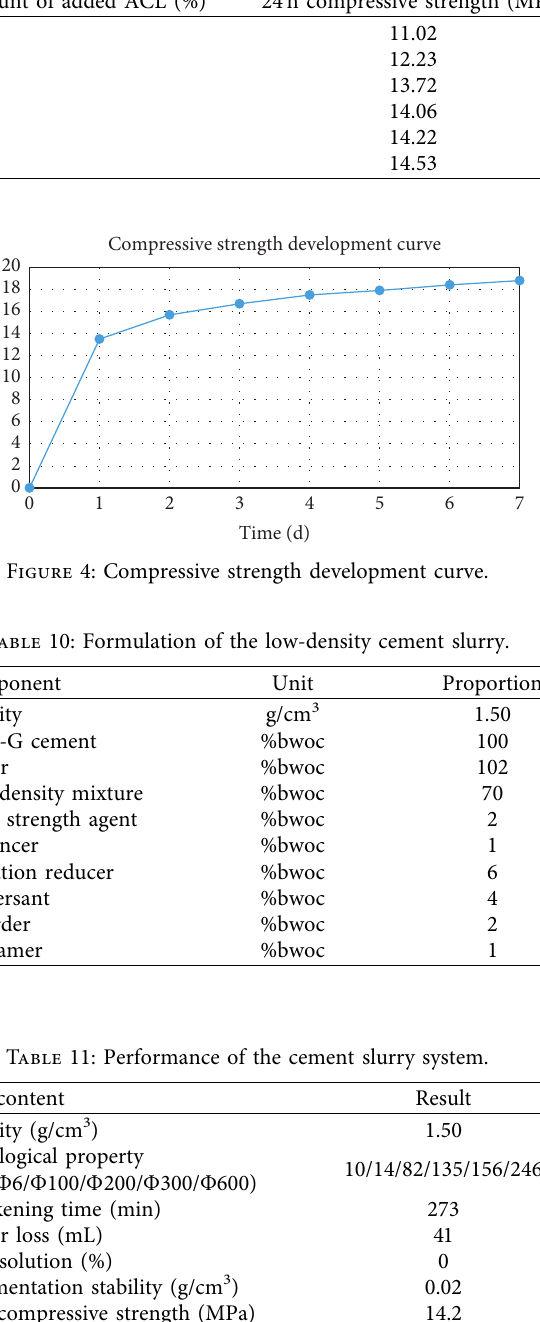
Table 9: Effect of the amount of added ACL on the performance of the low-density cement slurry. Amount of added ACL (%)